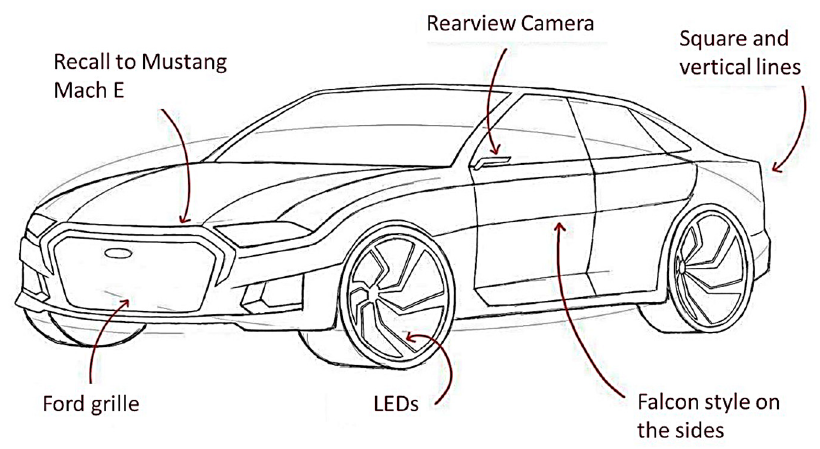
Figure 6. Final sketch of the proposed car style combining the four styles.